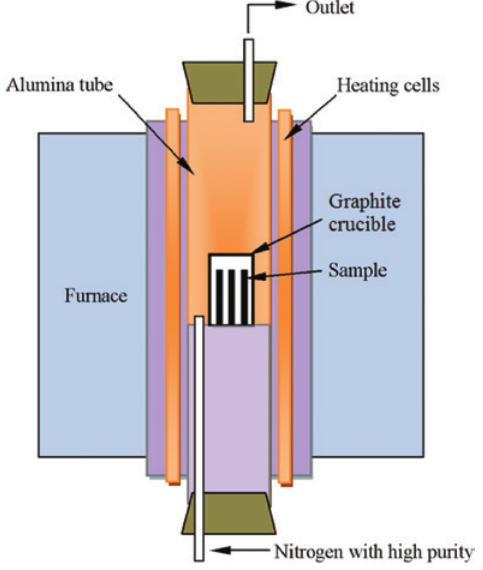
Fig. 1: The schematic diagram of the reaction equipment